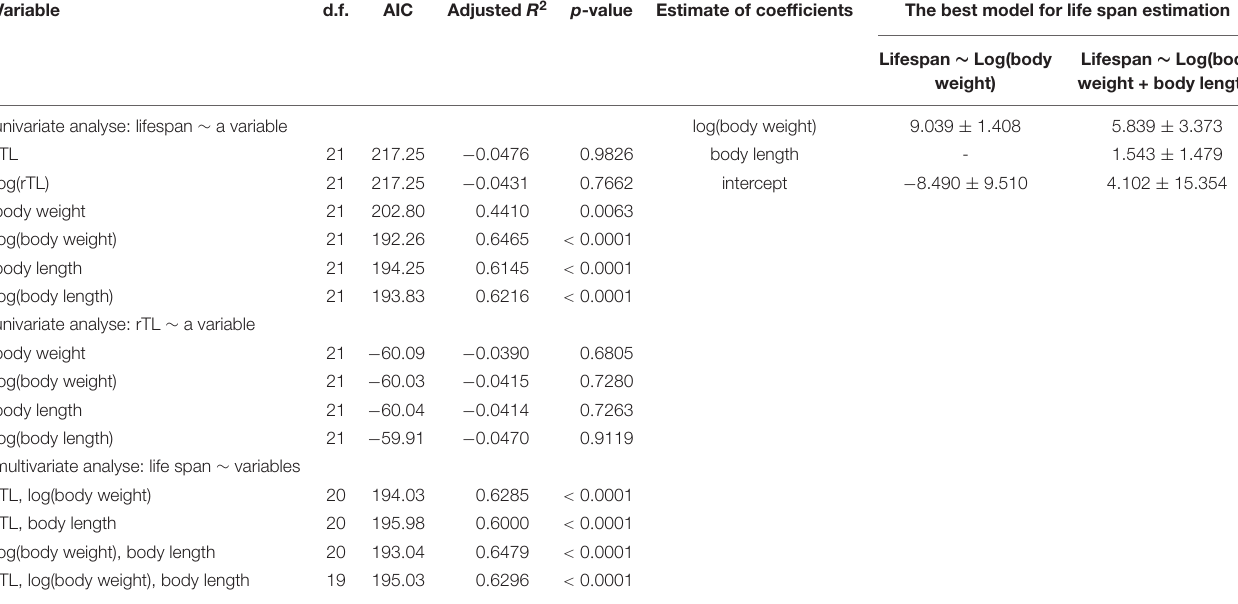
TABLE 4 | Mixed model for average lifespan using body weight, body length and median rTL for estimating average lifespan.